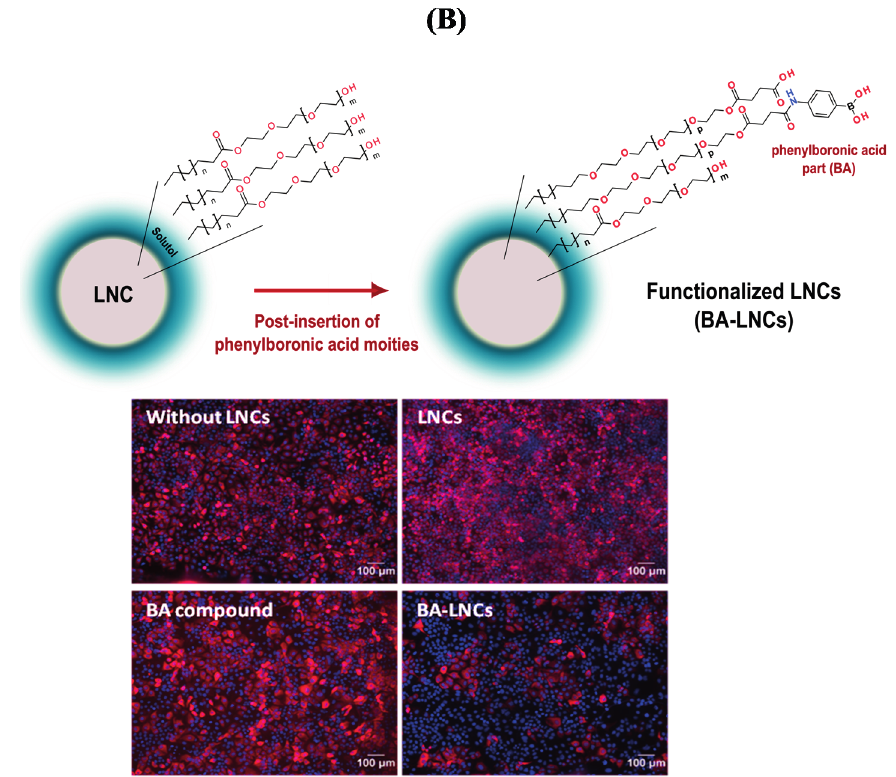
Figure 8. ( A ) Schematic illustration of the fabrication of boronic acid-modified nanoparticles and effect of particle concentration on the entry inhibition activity; ( B ) Formulation of boronic acid-modified lipid nanocapsules (BA-LNCs) together with HCV infection tests on the Huh 7 cell culture: Fluorescent image (10×) of the Huh 7 target cells after incubation with modified JFH1 virus for 48 h, incubation in the presence of the blank LNCs (80 µg/mL), BA compound (concentration of boronic acid moieties = 15 µM), and BA-LNCs (concentration of boronic acid moieties = 12.4 µM), along with absence of nanocapsules (red color and blue color correspond to infected cells and nucleus, respectively)